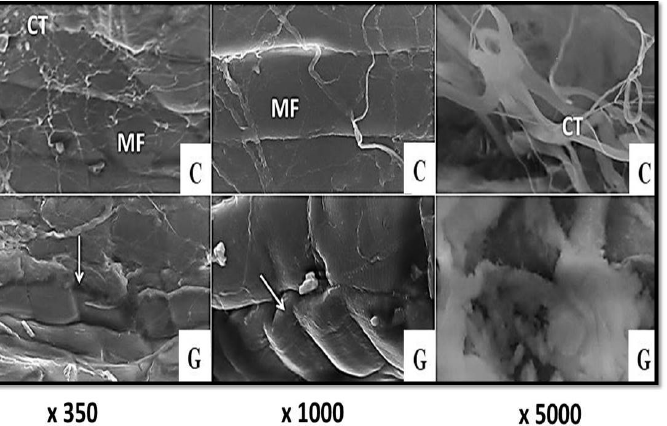
Figure 5. Scanning electron micrographs of camel semitendinosus muscle (×350, ×1000, and ×5000). C: control; G: ginger extract; MF: muscle fiber; CT: connective tissue. White arrows point to frag- mented muscle fibers.